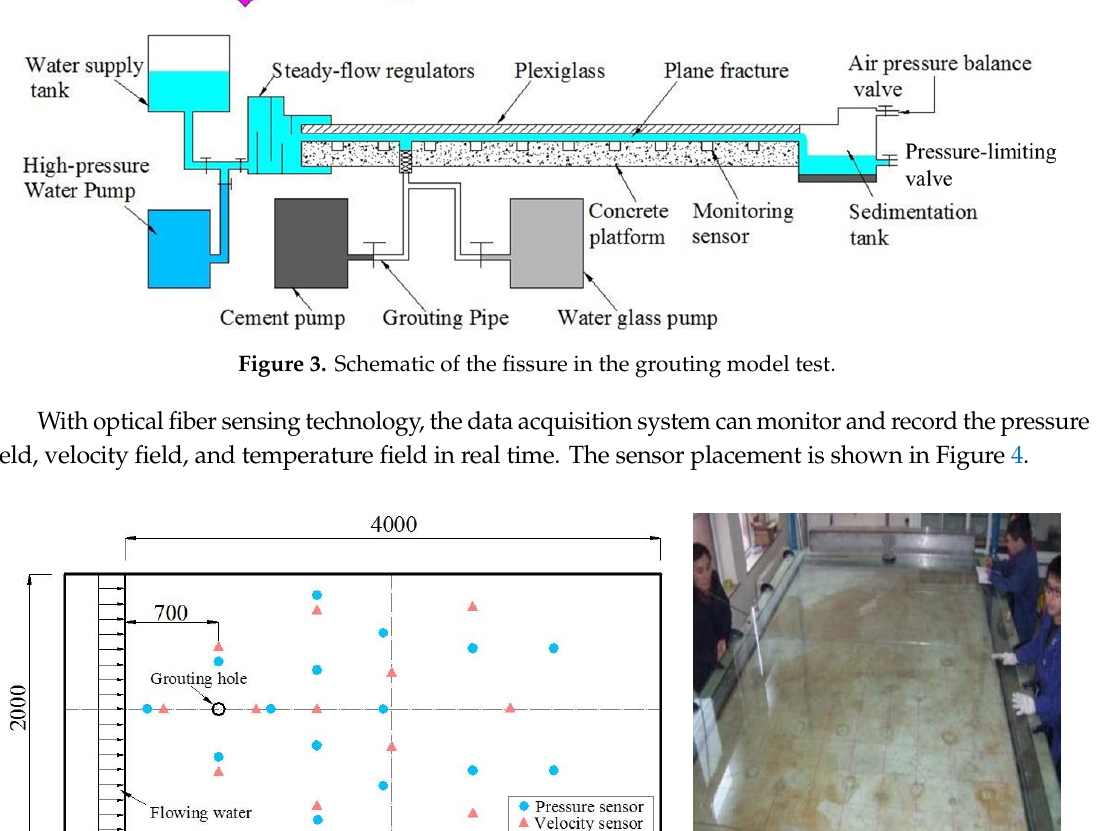
Figure 3. Schematic of the fissure in the grouting model test.